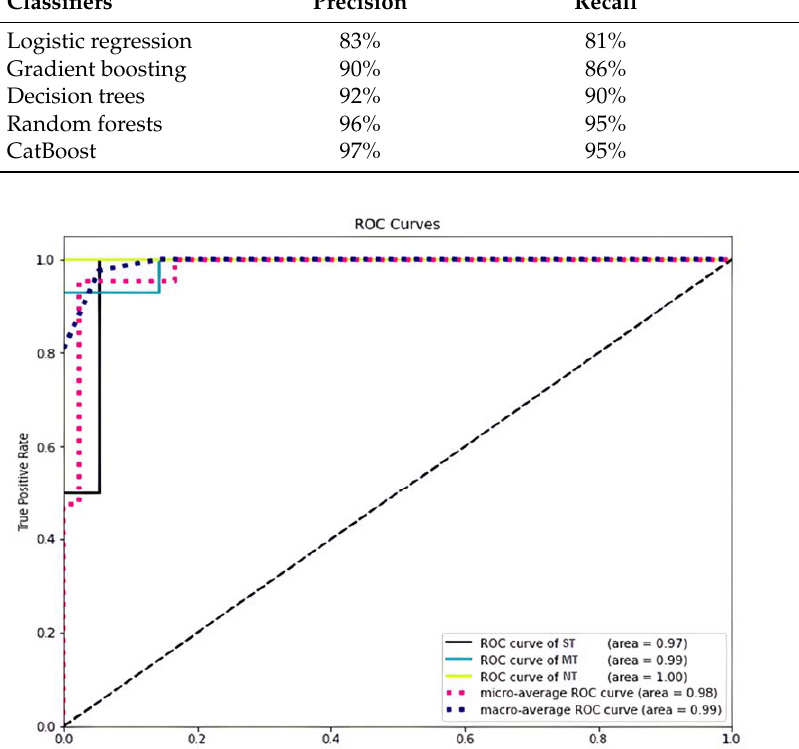
Figure 4. The ROC curve and the AUC of the CatBoost model. The ROC curve is made by plotting the rate of true positives as a function of the rate of false positives. The black line represents the correct predictions of the STs, the light blue line represents the correct predictions of the MTs, and the yellow line represents the correct predictions of the NTs. Micro ‐ and macro ‐ average ROC curves are also represented by the dotted pink line and the dark blue dotted line, respectively.